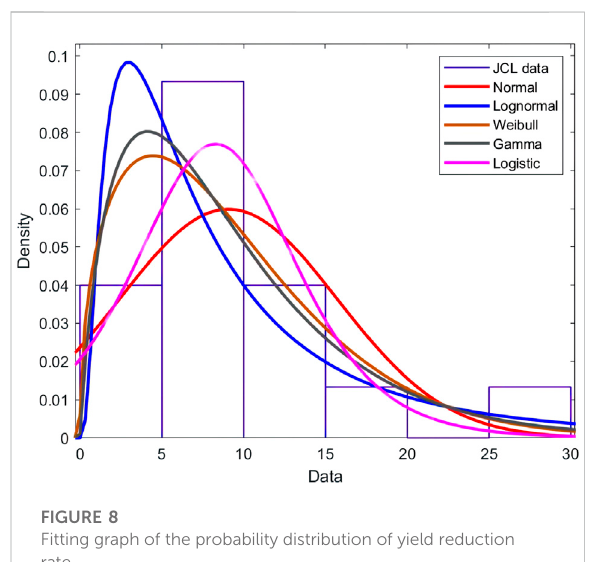
FIGURE 8 Fitting graph of the probability distribution of yield reduction